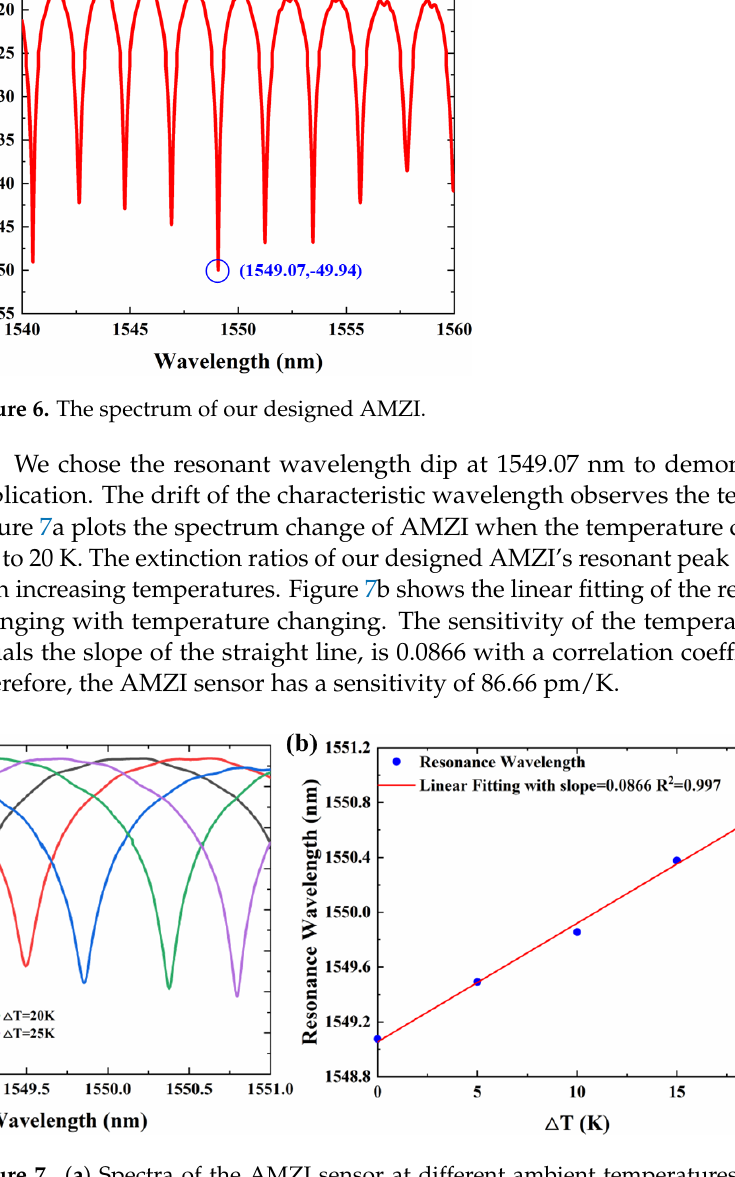
Figure 7. ( a ) Spectra of the AMZI sensor at different ambient temperatures. ( b ) Resonant peak wave-length at different temperatures and linear fitting.